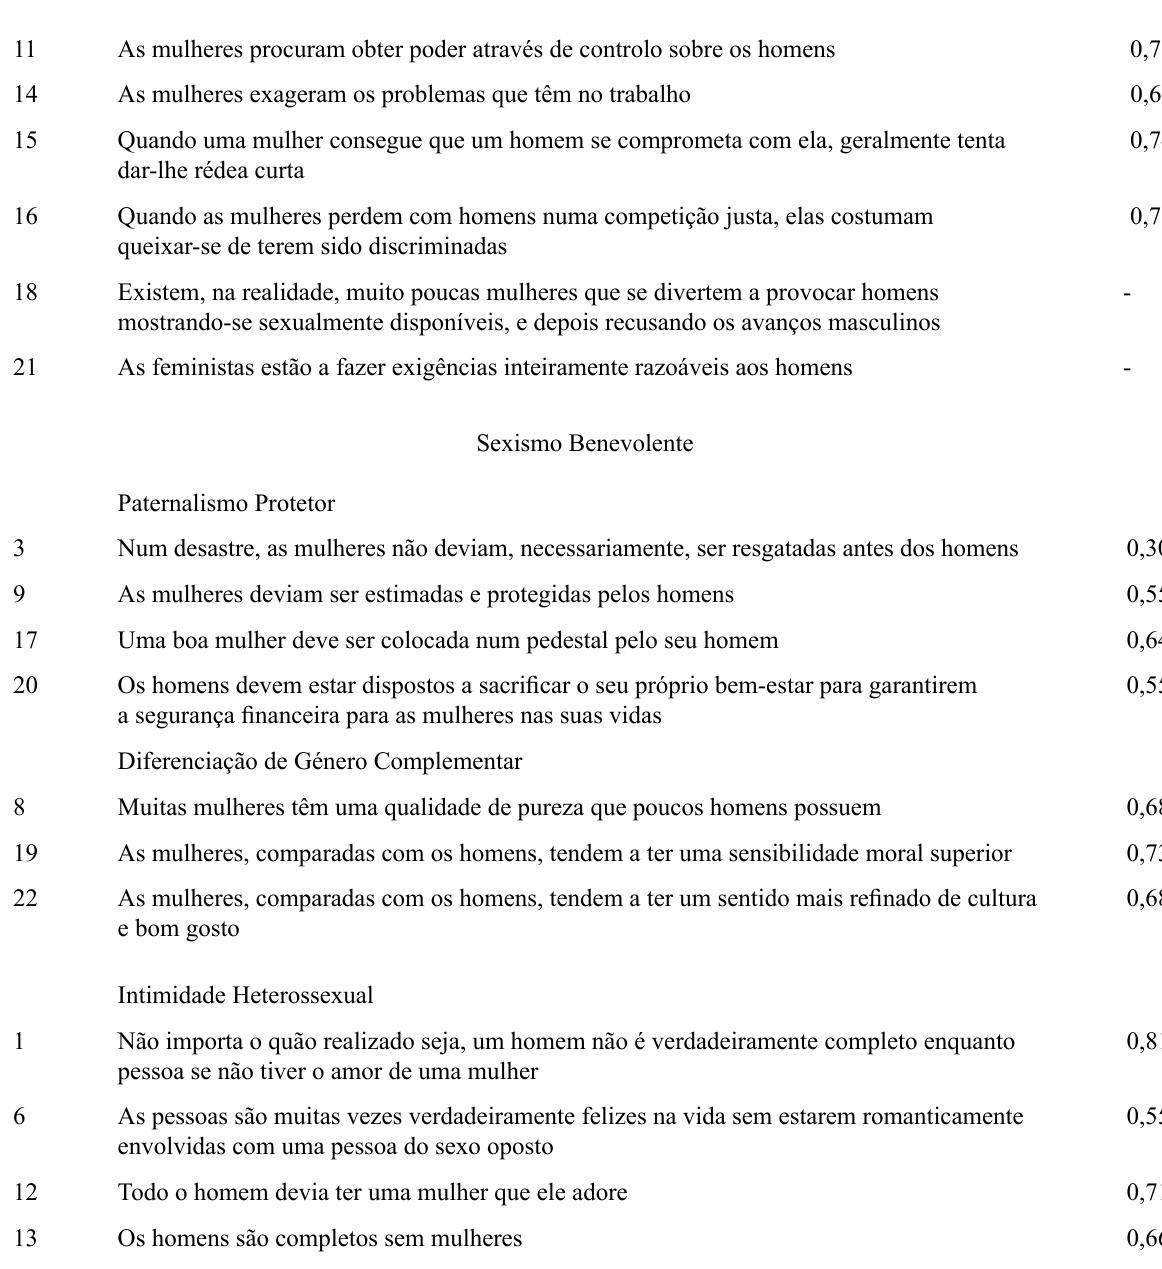
mente no seu fator, e todos os fatores de 1ª ordem pesaram